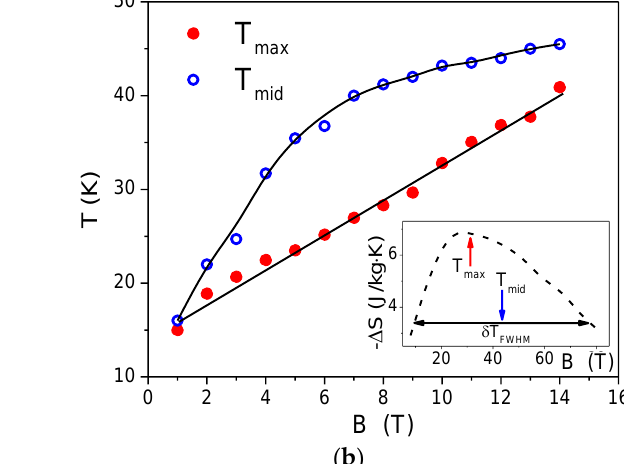
Figure 4. Temperature dependences of the change in the magnetic part of the entropy at various changes in the magnetic field of TbCo 2 H 2.4 ( a ); field dependences of the maximum temperature −Δ S(T max ) and the temperature of the middle of the working zone (T mid ) ( b ). It is clearly seen that the temperature at which the maximum MCE (T max ) is observed increases with an increase in the external magnetic field. Figure 4b shows the field dependences of the T max and the temperature (T mid ) in the middle of the working zone. The working zone is defined as the temperature range at which the values Δ S = 0.5 . ( Δ S max ) (see inset to Figure 4b). It can be seen that the dependence T max (B) demonstrates a linear increase in applied fields, while the dependence T mid (B) approximates to saturation. Figure 5a shows a comparison of the MCE values for the TbCo 2 H 2.4 hydride and the TbCo 2 sample at various magnetic field changes from 0 to 1, to 2, to 3, to 4, and up